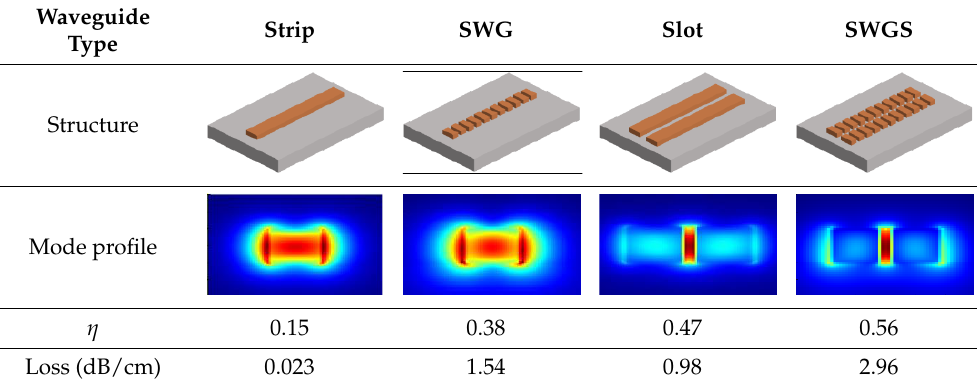
Figure 1. A cross-section schematic diagram of the proposed SOS-based structure ( a ) strip wave- guide; ( b ) slot waveguide.